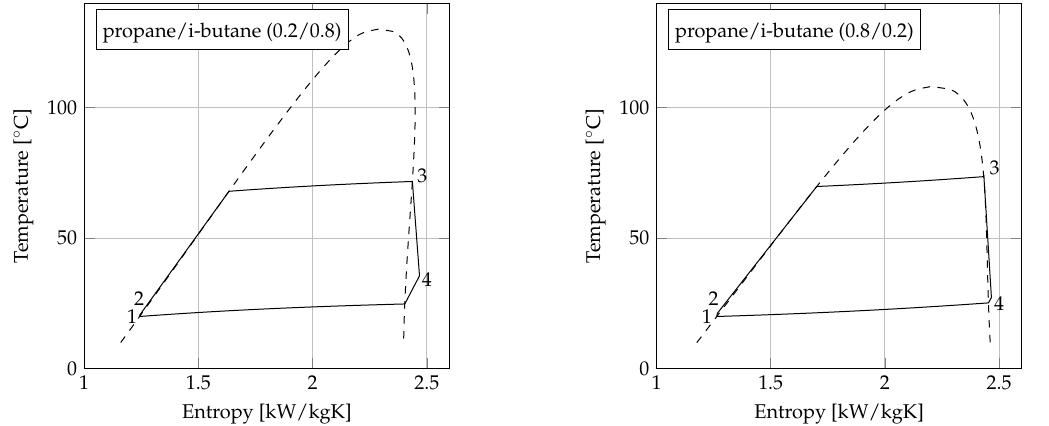
Figure 4. T , s -diagrams for the four ORC units using propane, i-butane, propane/i-butane (0.2/0.8), and propane/i-butane (0.8/0.2) with ∆ T pp , cond = 5 ◦ C.